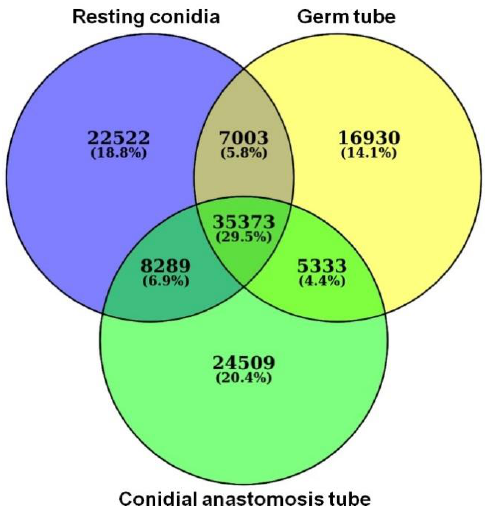
Figure 4. Venn diagram showing the number of transcripts in resting conidia, germ tube, and co- nidial anastomosis tube. anastomosis